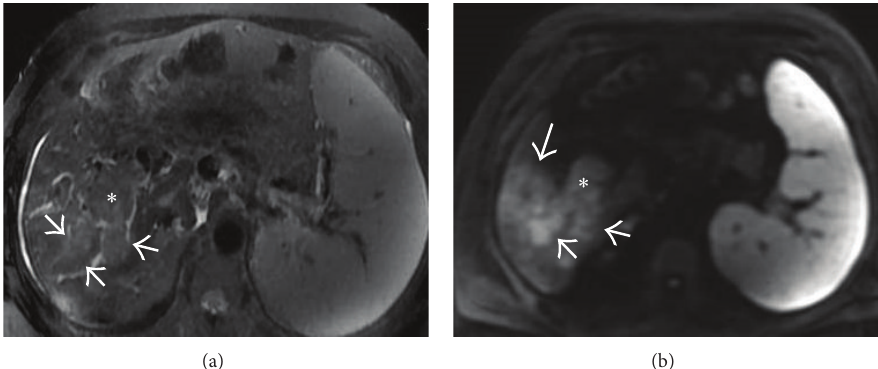
Figure 40: (a) Axial T2-weighted fat saturated image in a patient with liver cirrhosis and multifocal hepatocellular carcinoma showing occlusive heterogeneously hyperintense tumor thrombus (asterisk and arrows) expanding the right portal vein. It shows diffusion restriction (asterisk and arrows in (b)). One of the tumoral masses can also be seen on this image (thick arrow).